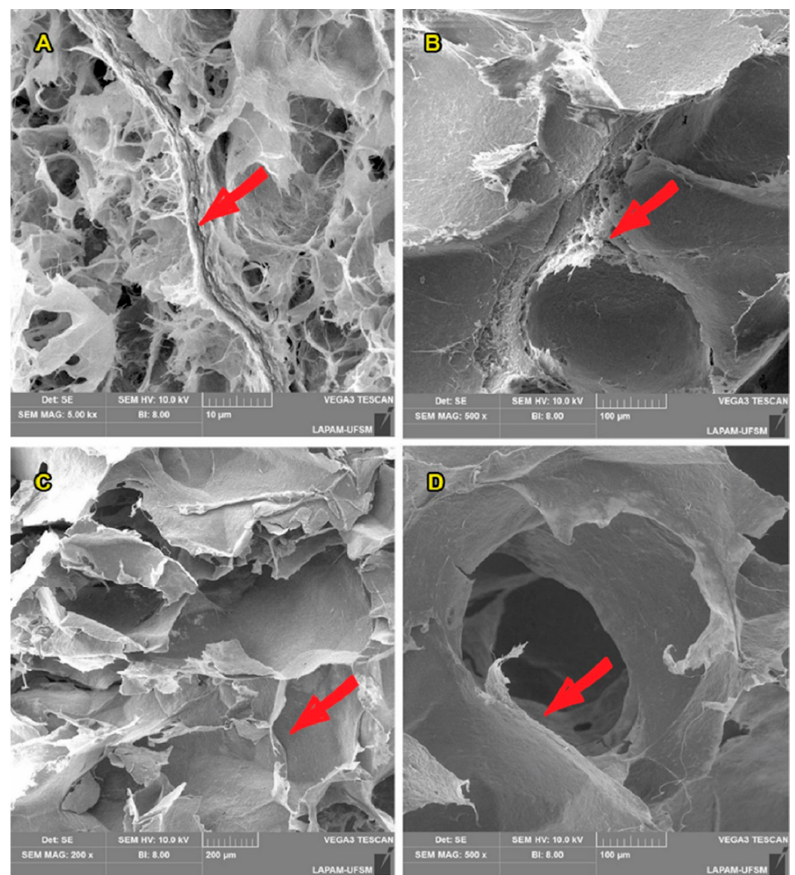
Figure 4. SEM micrographs of the NFC-based aerogels incorporated with alginate. Where the images ( A , B ) and ( C , D ) refer to the aerogels without and with TA extract, respectively. All the aerogels showed ductile curves (Figure 5A), which is a favorable feature, since they can be highly compressed and retain almost the same cellular shape (as shown in